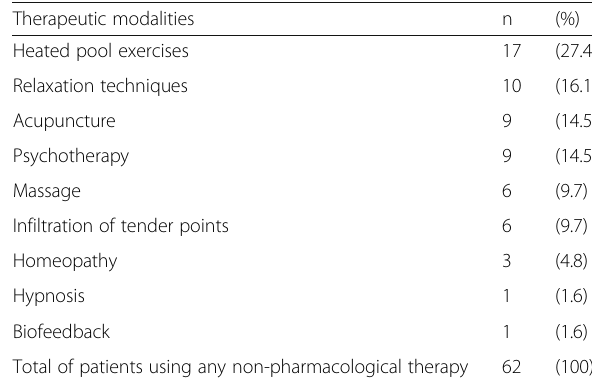
Table 2 Painkillers and sleeping pills used by patients with fibromyalgia